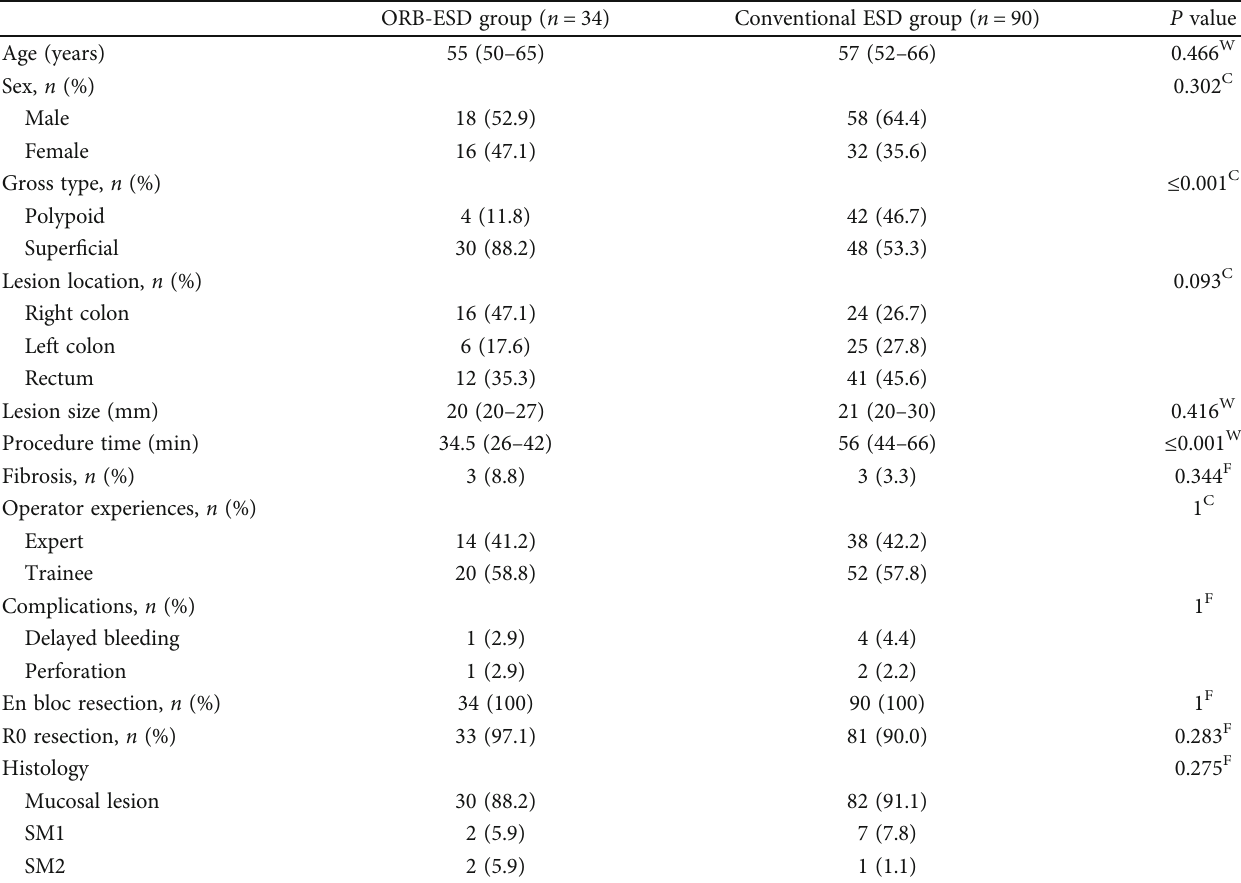
Table 1: Baseline patient characteristics and treatment outcomes in the entire cohort before propensity score matching (PSM).